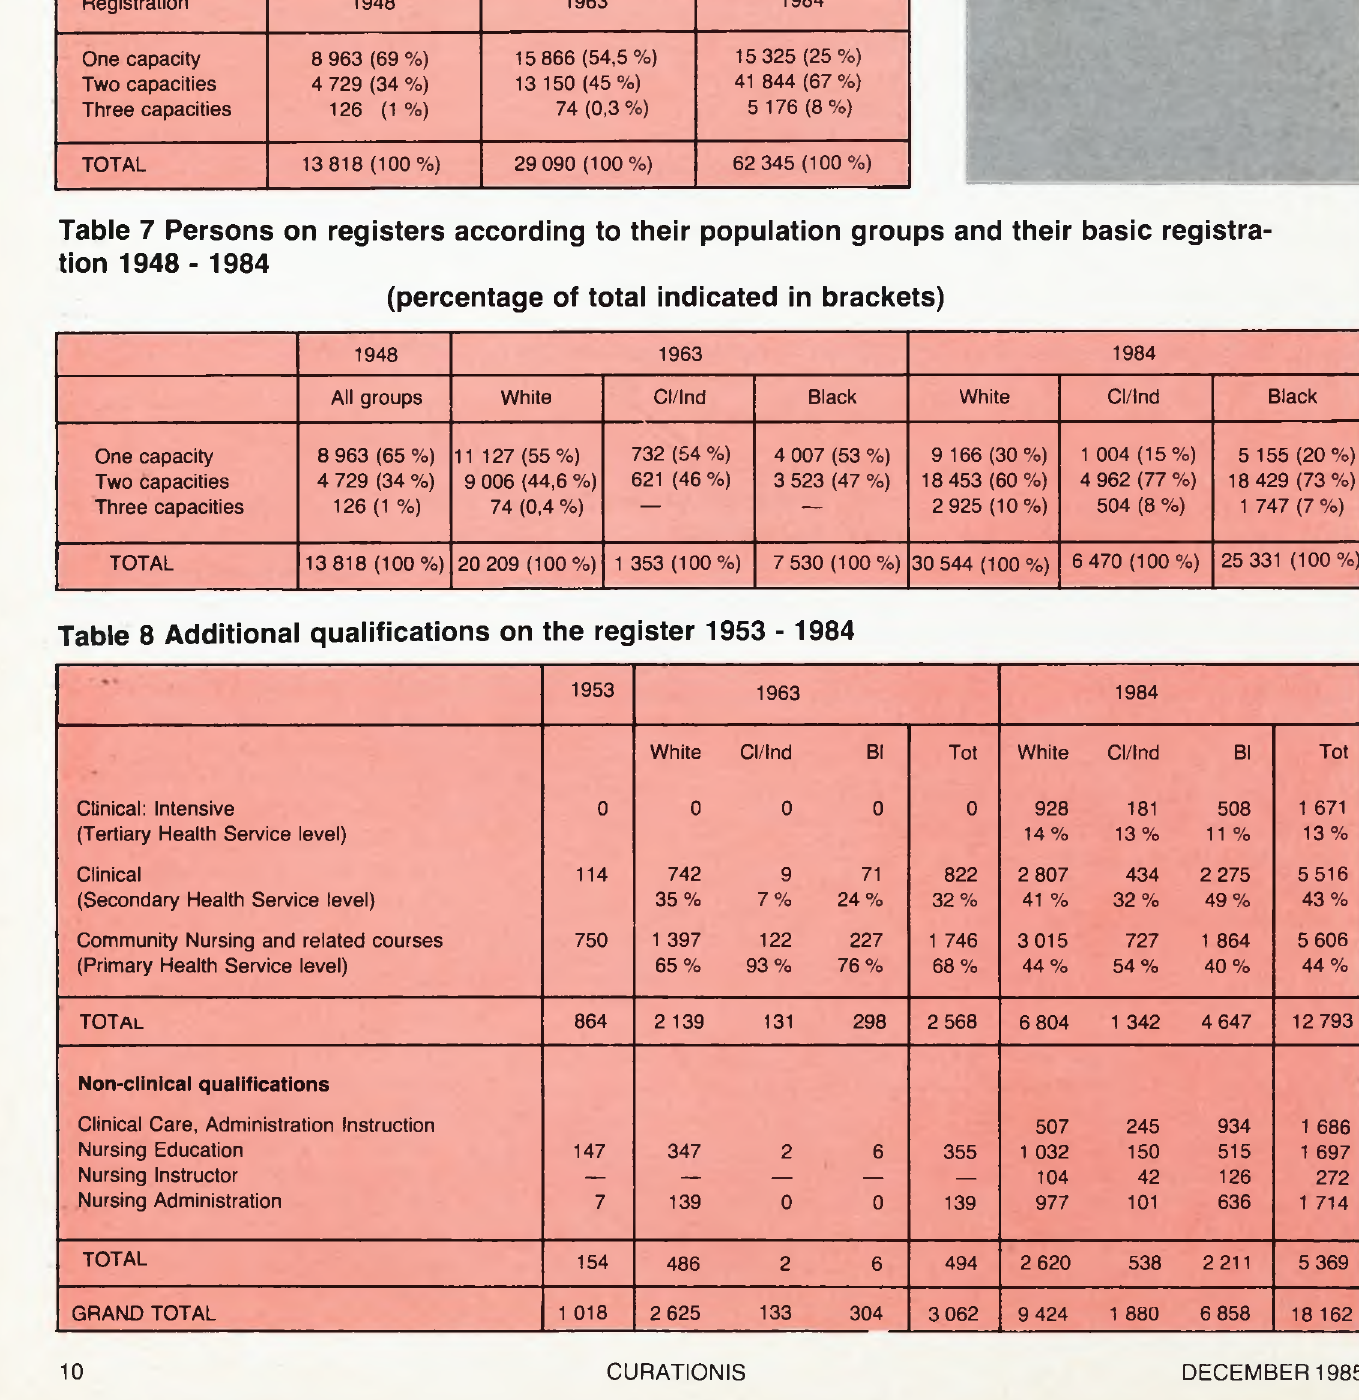
Table 6 Persons on registers in accordance with capacities of basic registration 1948-198429)